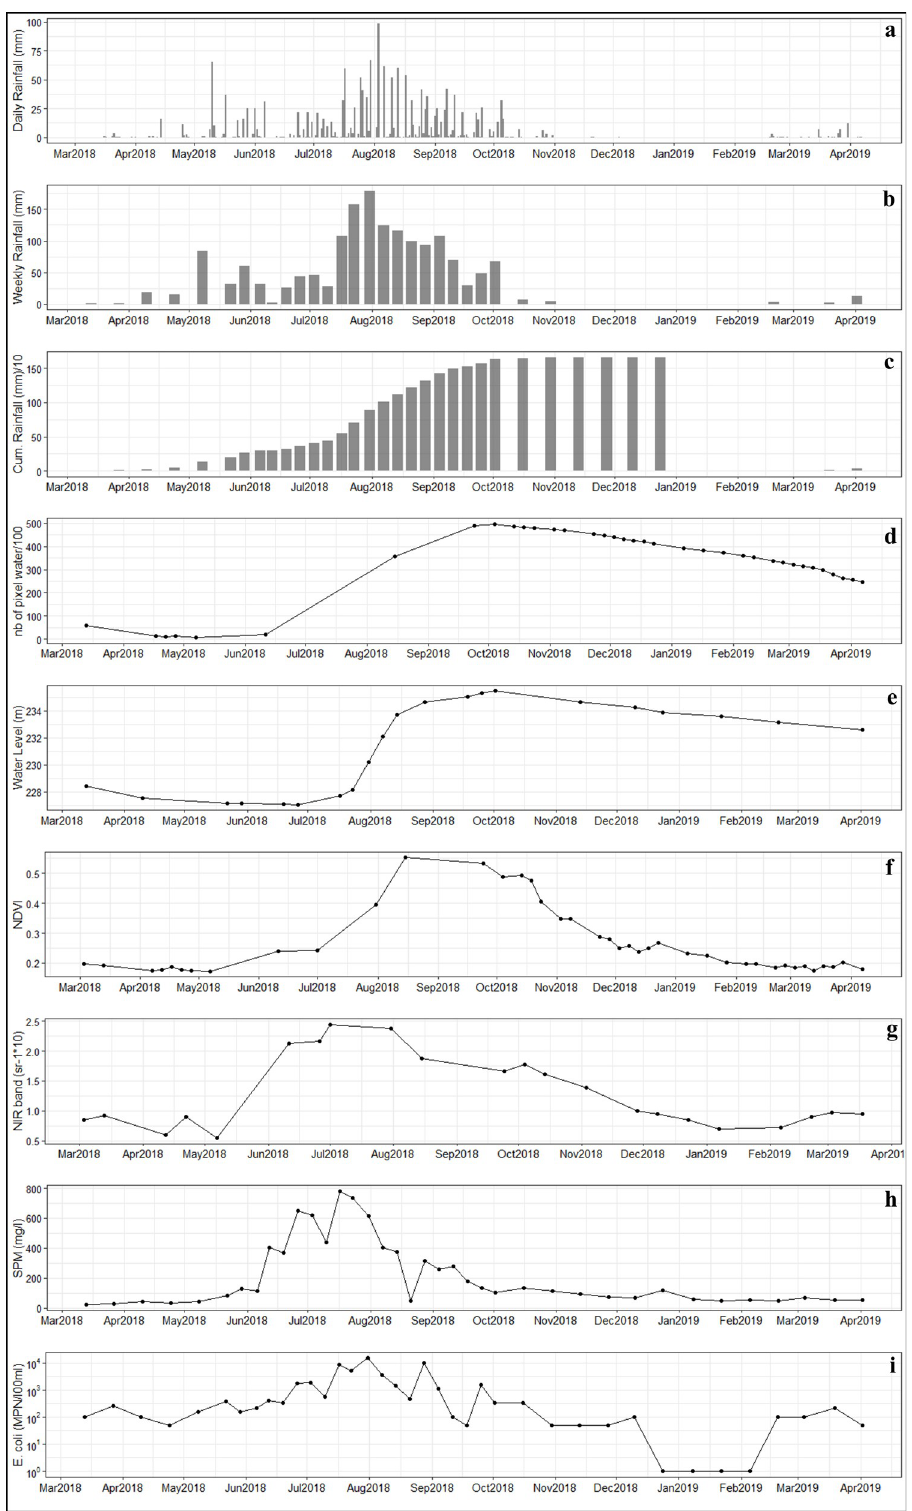
Fig 6. (a) Daily rainfall, (b) Weekly rainfall, (c) Cumulated weekly rainfall, (d) Number of water pixels from Sentinel-2 data, (e) Water level, (f) Average land NDVI from Sentinel-2 data, (g) Water NIR Reflectance (Sentinel-2), (h) SPM, (i) E . coli